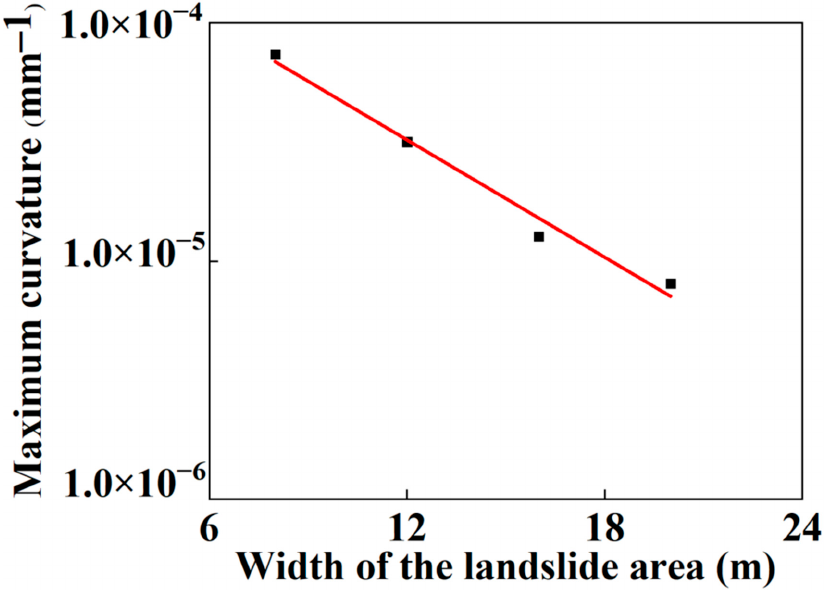
Figure 20. Variation in the maximum curvature of the SWW-RTP with different landslide area widths when the HDPE begins to yield.